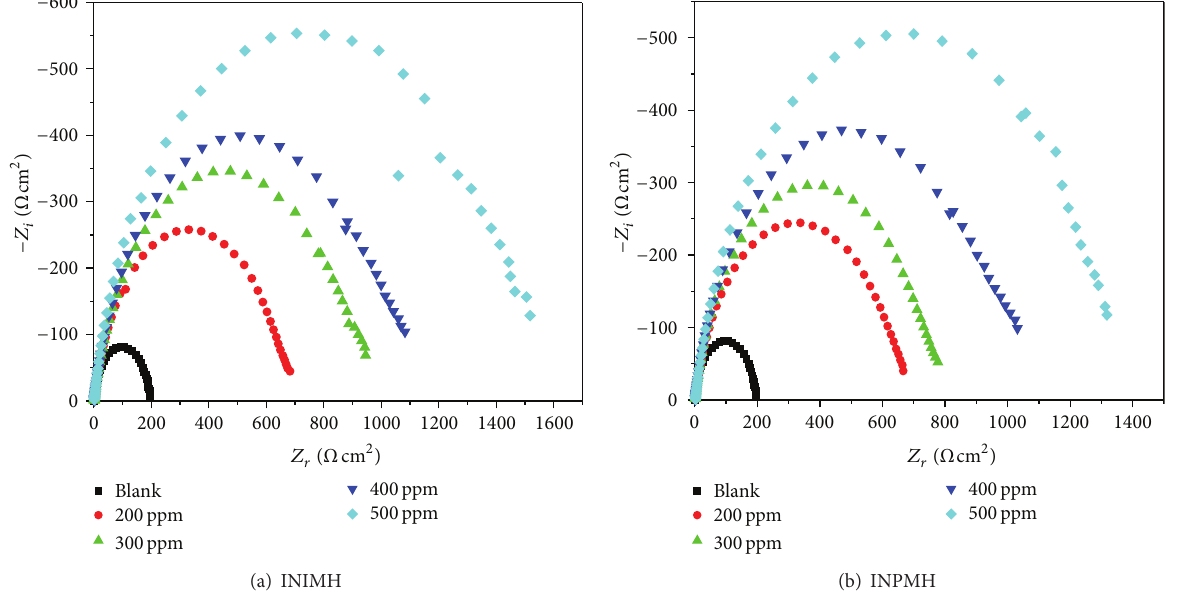
Figure 10: Nyquist plots for MS in 0.5 M HCl in the presence of different concentrations of (a) INIMH and (b) INPMH.